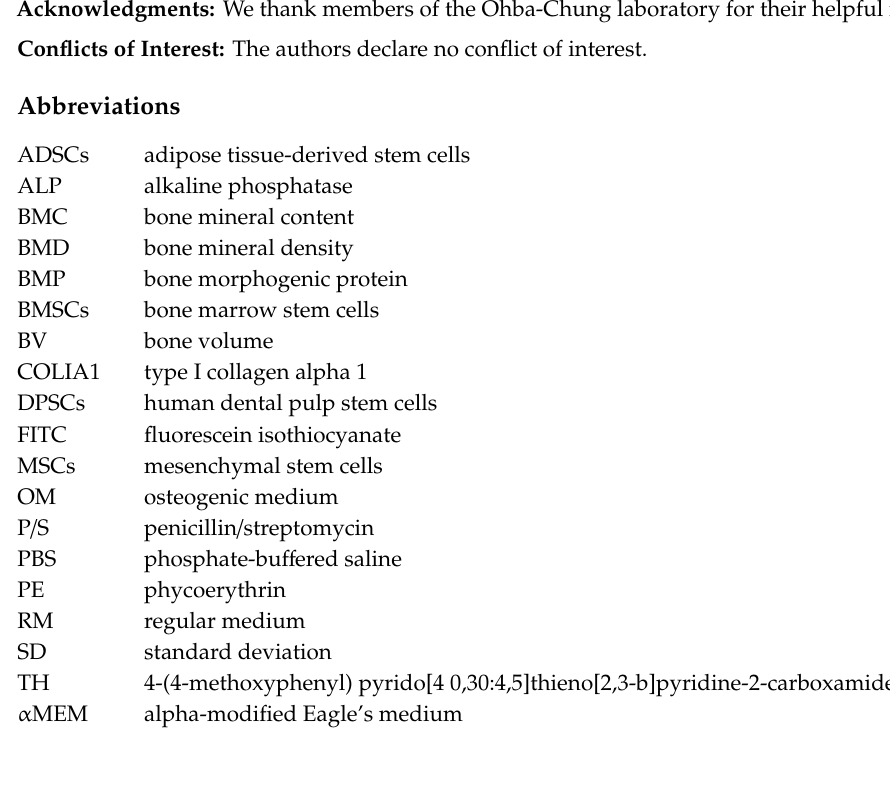
Table S1: Antibody dilutions and clone numbers for the FACS